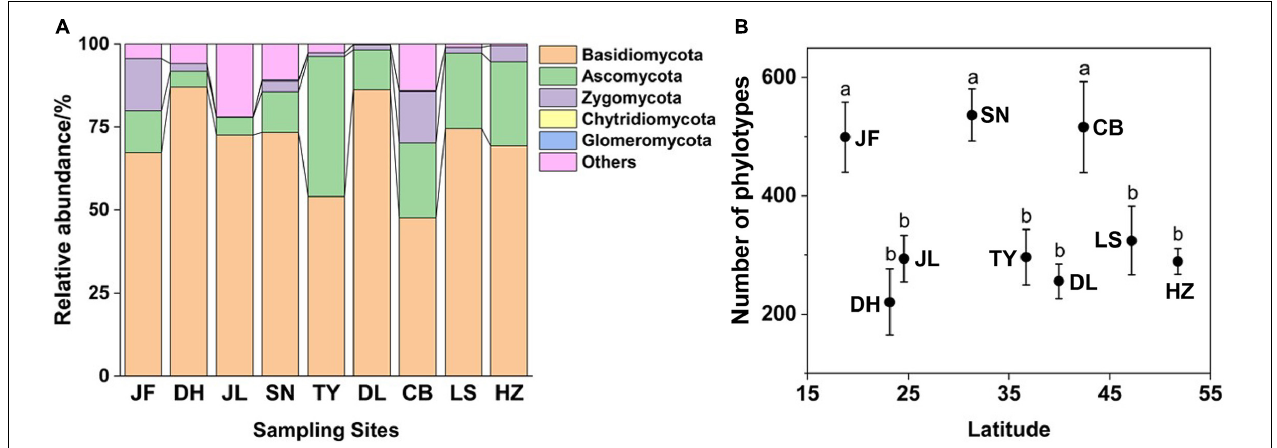
FIGURE 1 | Relative abundance of dominant fungal phyla (A) and phylotype richness (B) of nine forest ecosystems along north-south transect in eastern China. The sampling sites from south to north in order are JF, DH, JL, SN, TY, DL, CB, LS, and HZ. Different lowercase letters indicate significant differences among means ( p < 0.05). Error bars represent standard error of the mean.